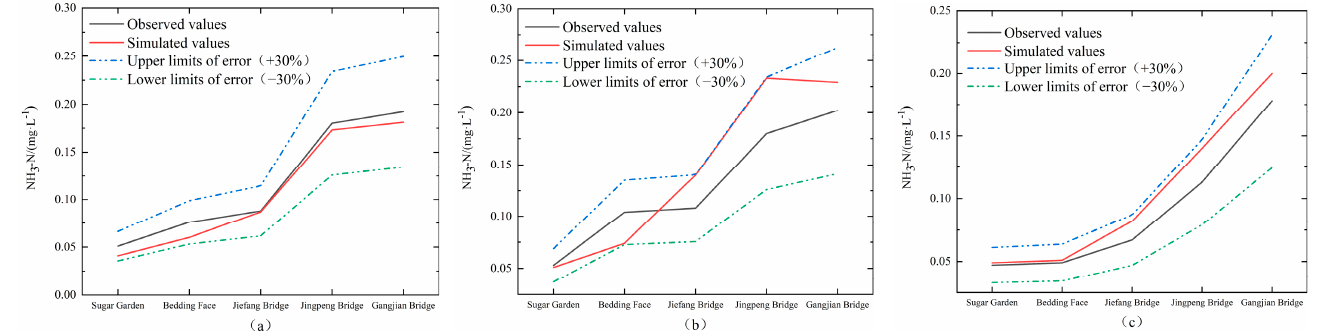
Figure 3. Comparison of measured and simulated values of NH 3 -N concentration and error range during the ( a ) wet season, ( b ) normal season, and ( c ) dry season.